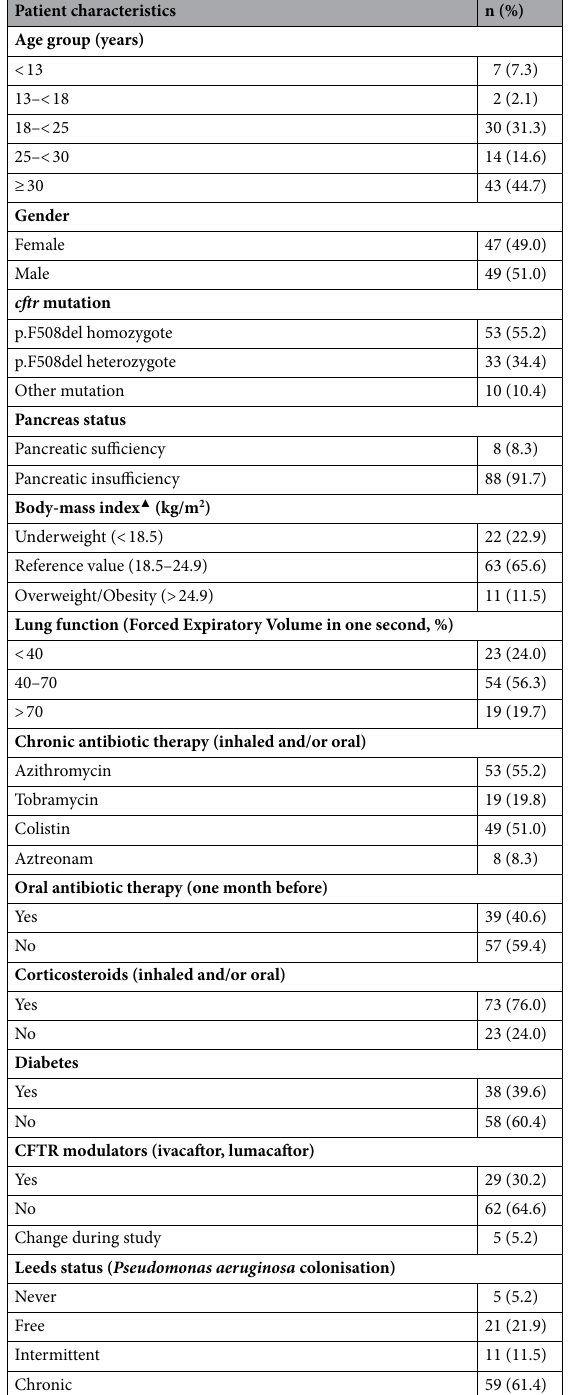
Table 1. Study cohort (96 people with cystic fibrosis): demographic and clinical